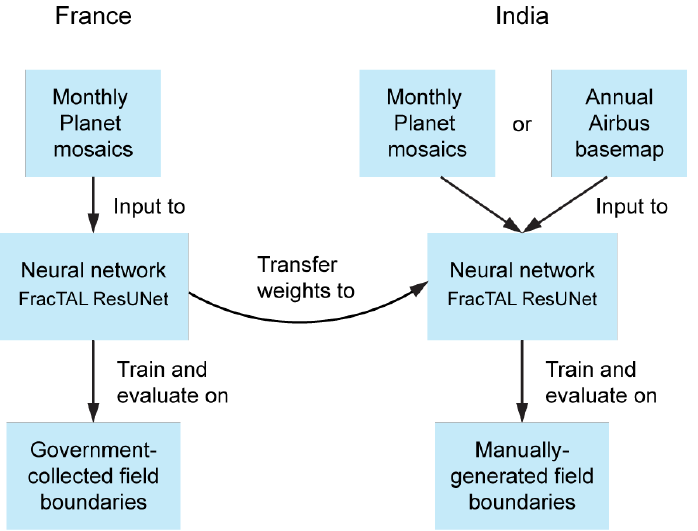
Figure 4. Overview of field delineation experiments. A model is first trained on imagery and field boundary labels in France before being transferred to delineate fields in